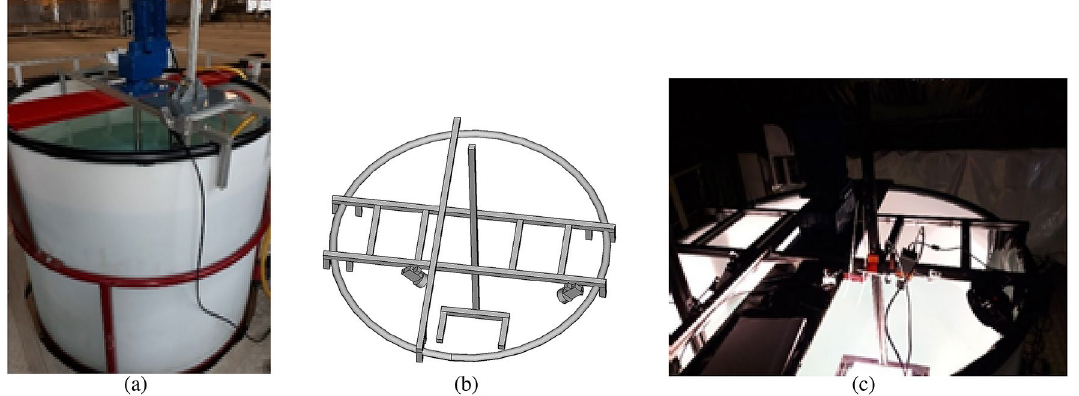
Figure 8. Experimental setup. ( a ) Water tank with the electrical mixer attached to an aluminium frame, ( b ) schematic of a custom-made aluminium frame with an adjustable arm for varying depth of sample below water surface with two light source attached above the water surface. ( c ) Set-up of the tank covered with black